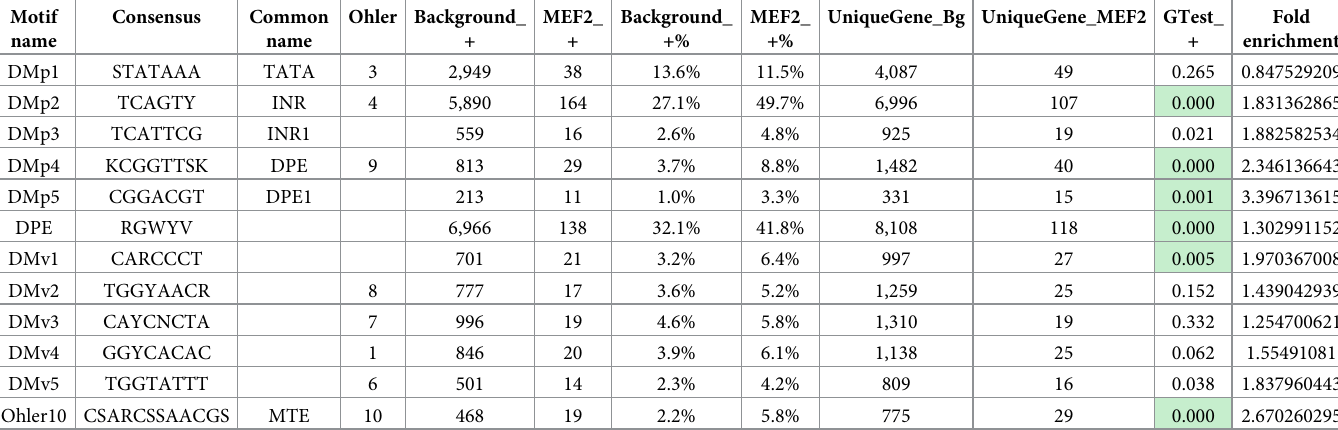
Table 1. Enrichment of directional promoter motifs in background and MEF2 target